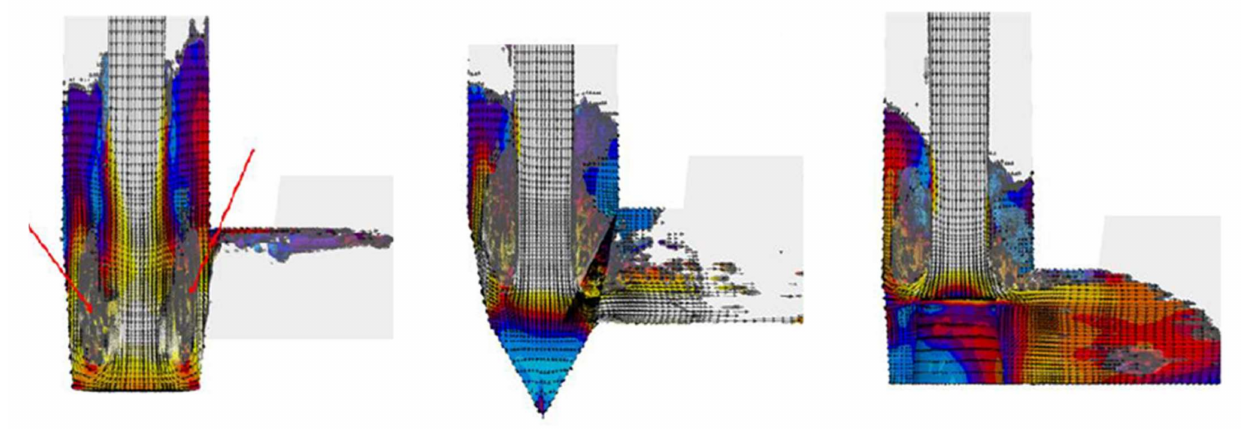
Figure 4. Initial filling phase of the sprue in expanded sprues (with reverse tapering) characteristic of automatic molding with horizontal parting plane